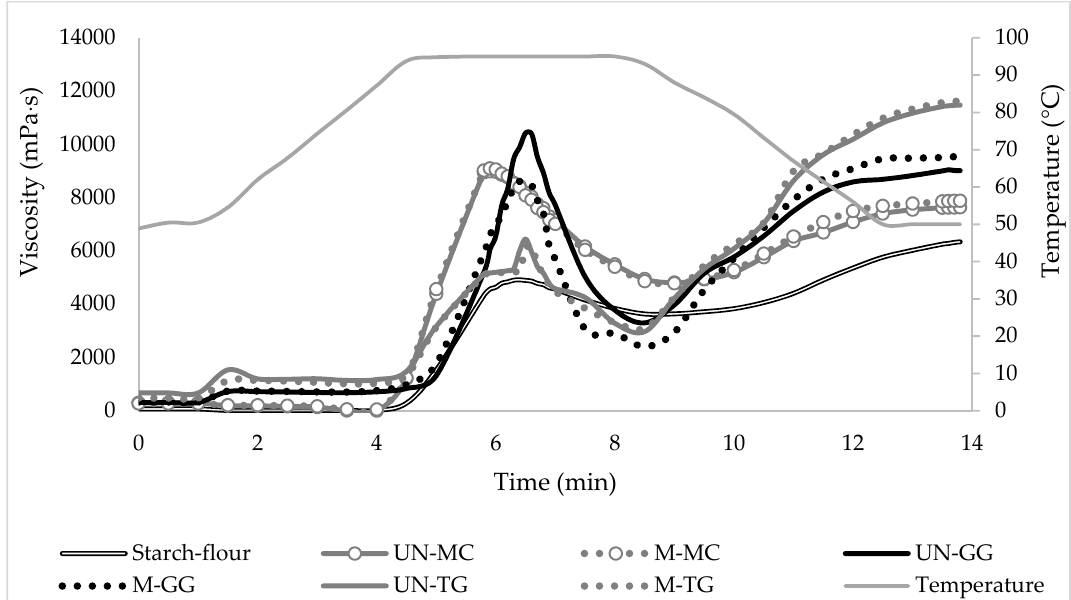
Figure 3. Viscometric profiles of the corn starch/rice flour system in the absence and presence of single milled and un-milled hydrocolloids. UN: un-milled; M: milled; GG: guar gum; TG: tara gum; MC: methylcellulose.